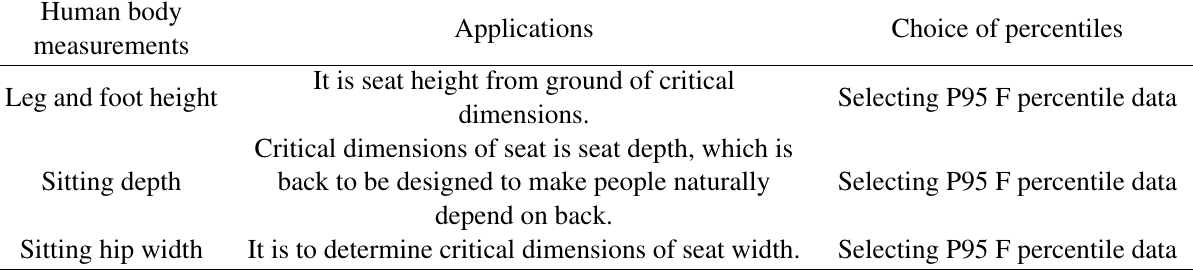
Table 3 Horizontal dimension of human